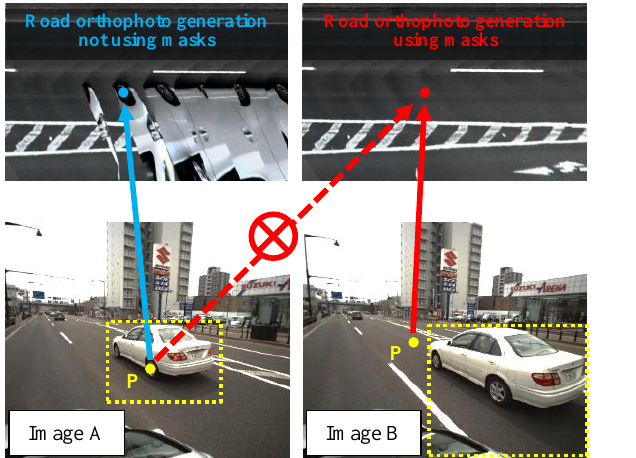
Figure 2. Road orthophoto generation